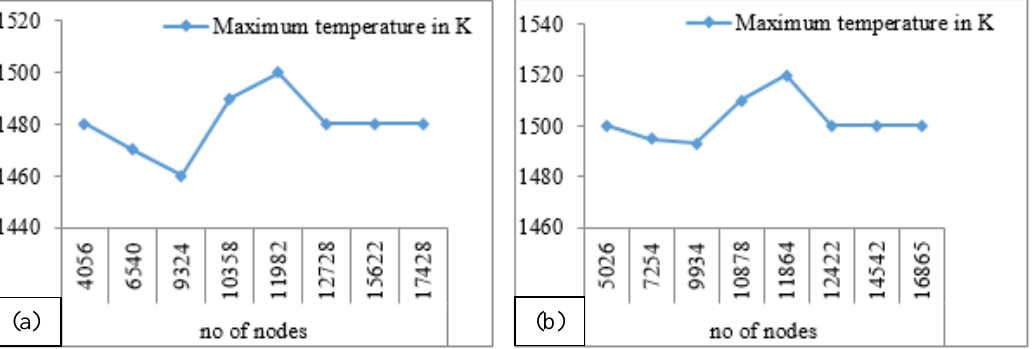
Figure 4. Grid independence test for the modified systems having (a) channel type combustion chamber and (b) nozzle type combustion chamber.